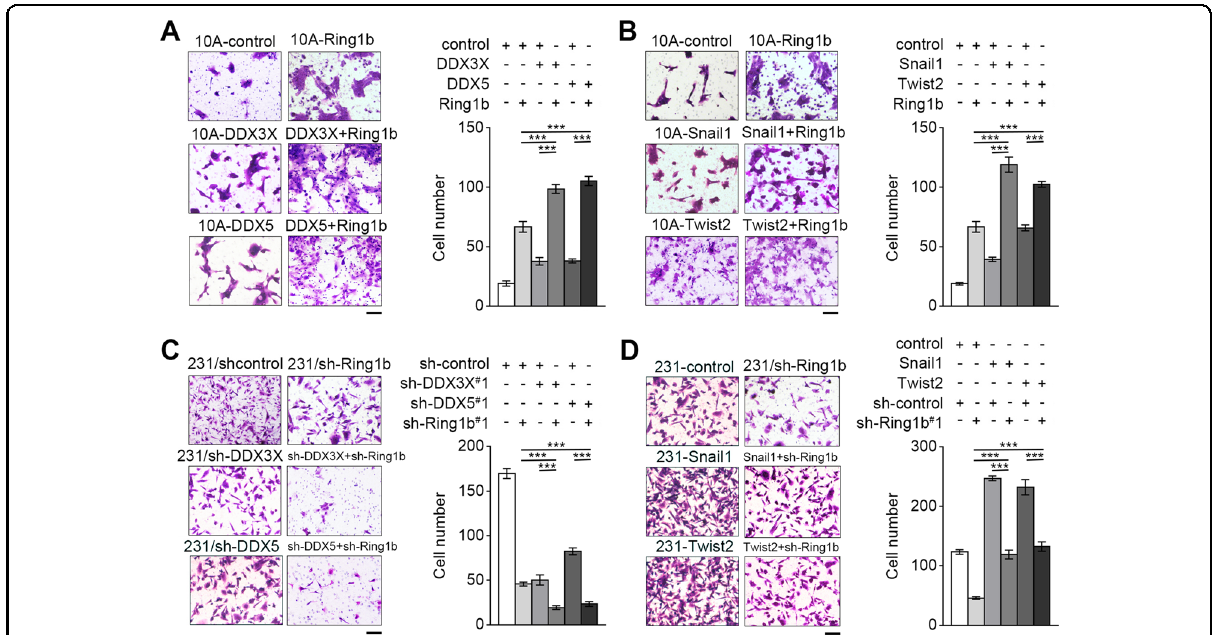
Fig. 4 Ring1b complexes promote invasion in breast cells. Proteins as indicated were stably overexpressed or knocked down in cells using lentivirus. A – D Effect of Ring1b complexes on cell invasion in 10 A and 231 cells. Statistical analysis for cells migration and invasion by Transwell assays are presented in the bar graphs. Scale bar, 60 μ m. Error bars represent the means ± SEM. Unpaired t -test is performed to indicate a statistically signi fi cant difference. *** P <